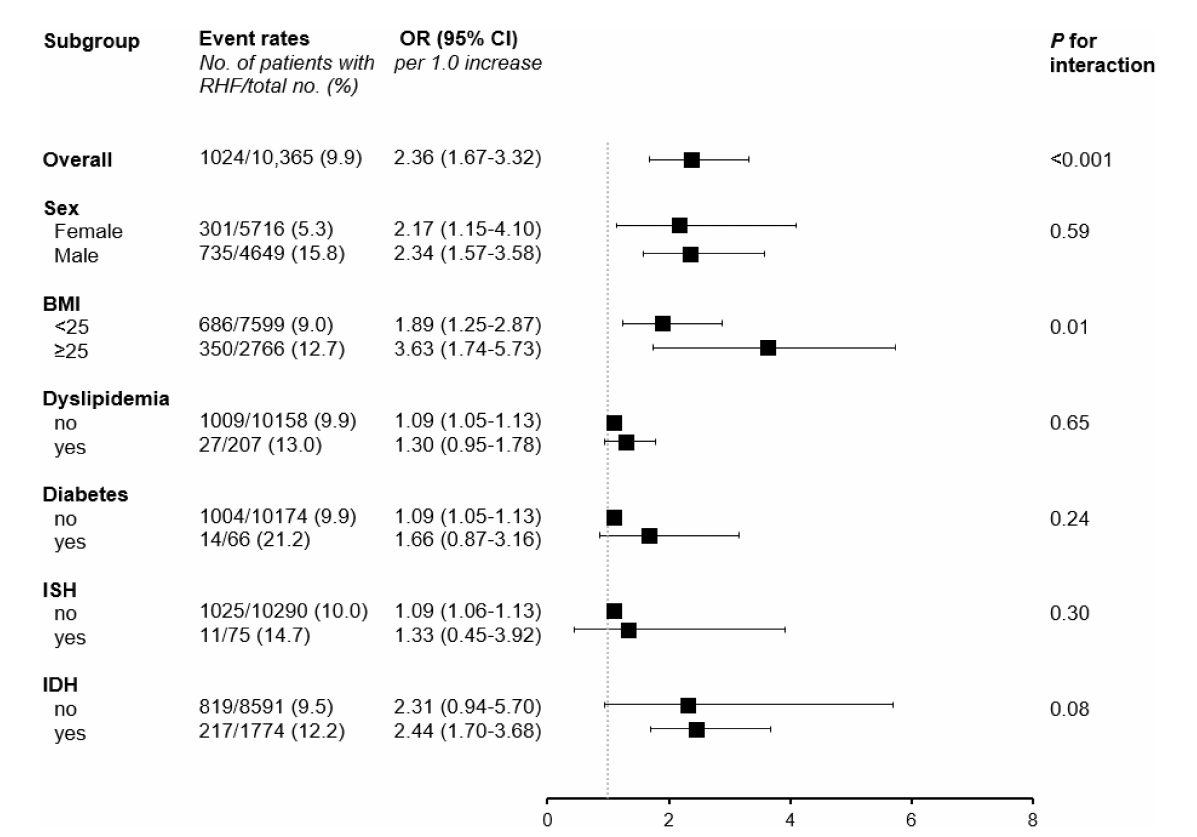
FIGURE3 Subgroup analyses stratified by sex, BMI, histories of diabetes or dyslipidemia, and ISH or IDH. ORs were calculated per 1.0 increase of log-transformed PP levels after adjustment for age, sex, BMI, income, education alcohol and smoking status, history of diabetes, hemoglobin, total cholesterol, and proteinuria. RHF, renal hyperfiltration; OR, odds ratio; CI, confidence interval; BMI, body mass index; ISH, isolated systolic hypertension; IDH, isolated diastolic hypertension.